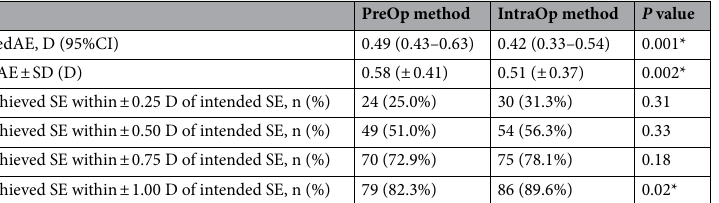
Table 2. Comparison of refractive prediction error between groups. Despite a statistically significant difference between median (MedAE) and mean (MAE) absolute errors ( P = 0.001, P = 0.002, respectively), the preoperative (Barrett True-K formula) and intraoperative (ORA) groups are clinically comparable in predictive refractive accuracy. There was no statistically significant difference between the two methods for an intended target refraction up to ± 0.75 D. Interestingly, ORA led to a higher number of eyes falling within ± 1.00 D of intended target refraction as compared to the Barrett True-K formula ( P = 0.02). PreOp preoperative method, IntraOp intraoperative method, MedAE median absolute error, MAE mean absolute error, SE spherical equivalent, *statistically significant.